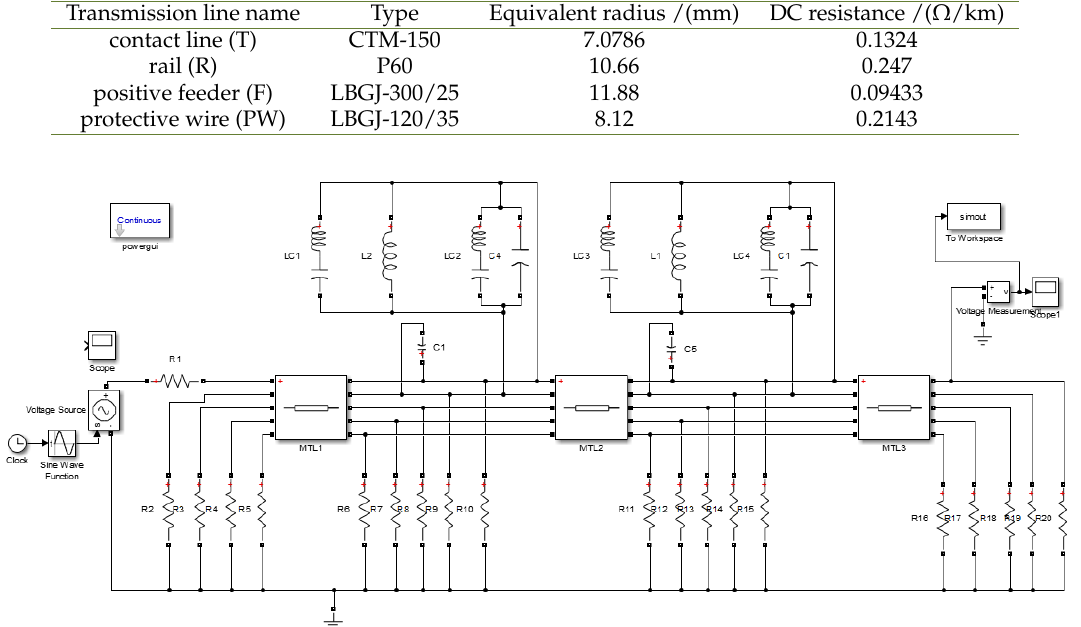
Table 2. Transmission line parameters of AT traction network.